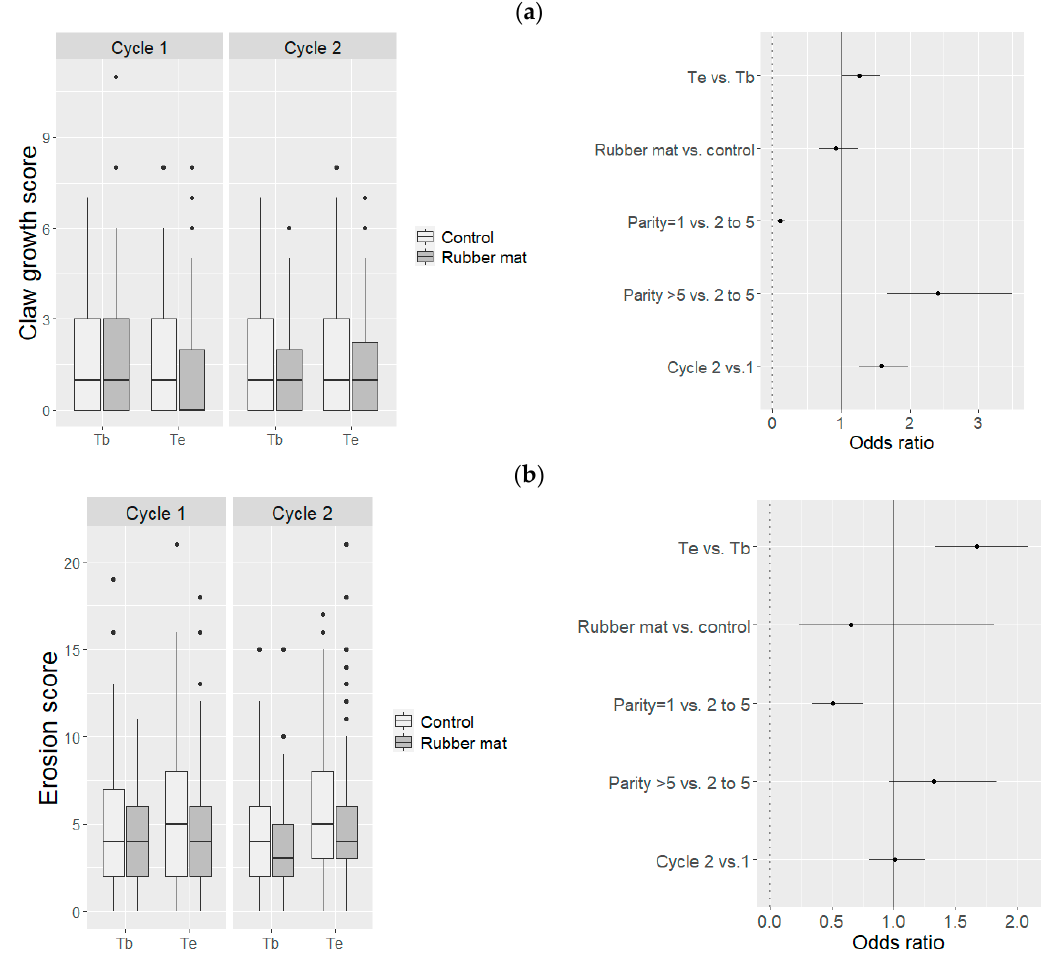
Figure 5. Distribution of ( a ) claw growth-defect scores, ( b ) claw-erosion scores and estimated odds ratios (with 95% con- fidence intervals) related to mild or severe forms of those conditions according to the floor type and gestation cycle, at the beginning (Tb) and the end (Te) of the gestation period.